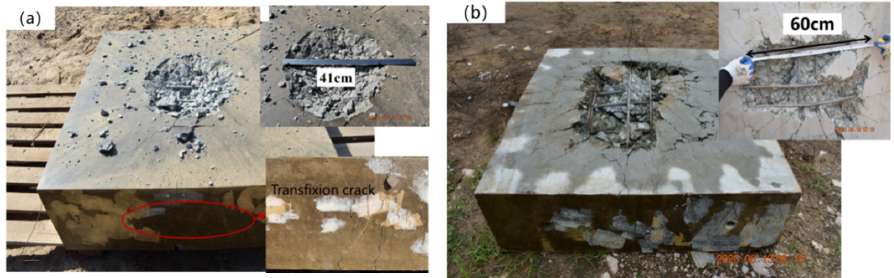
Figure 11. Failure modes of uncoated reinforced concrete slab after contact explosion: ( a ) face surface blast; ( b ) back surface blast.